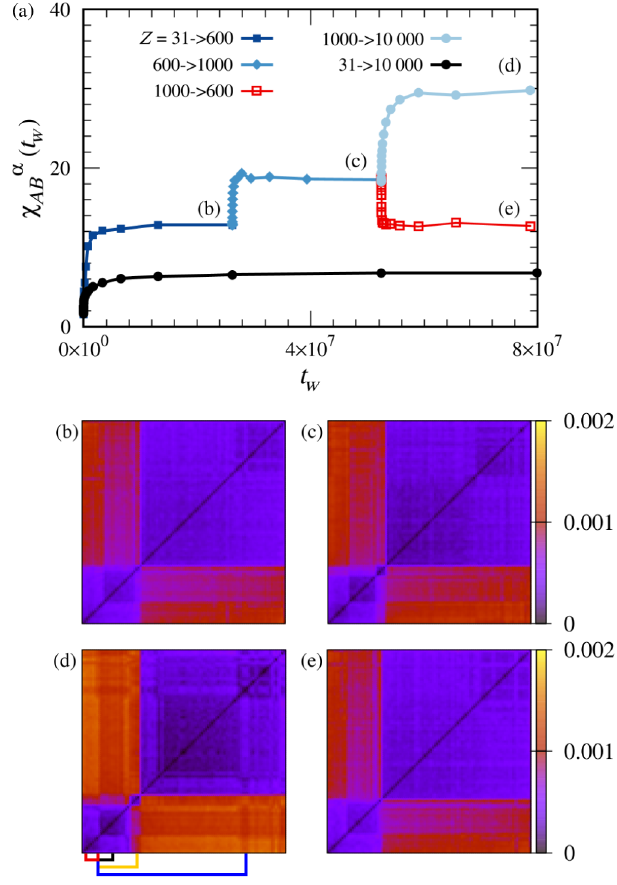
FIG. 11. Hierarchical landscape of sample α revealed by a multistep compression protocol. (a) Time evolution of the ð t Þ , in the various histories indicated by keys. susceptibility χ α w ab ¼ 100 for N (b) – (e) Corresponding heat maps of distances Δ α c ab clones, at times indicated in (a). In particular, in (d) the map at Z ¼ 10000 clearly reveals a hierarchical structure with states within states. The selected pairs of clones (i) – (iv) in (d) are used to construct the snapshots in Fig.